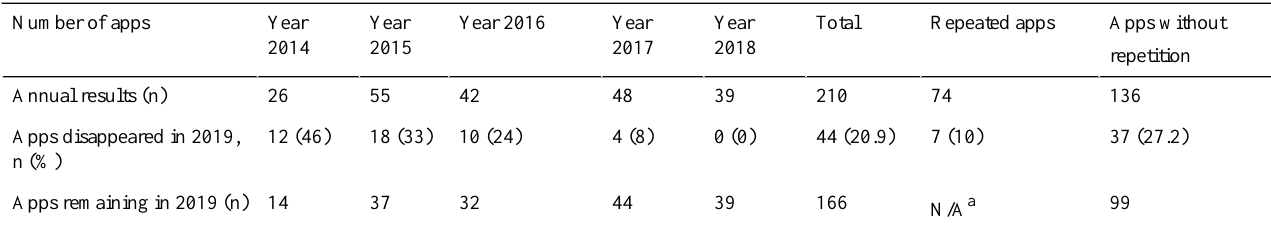
Table 4. Stability of the results through the years.